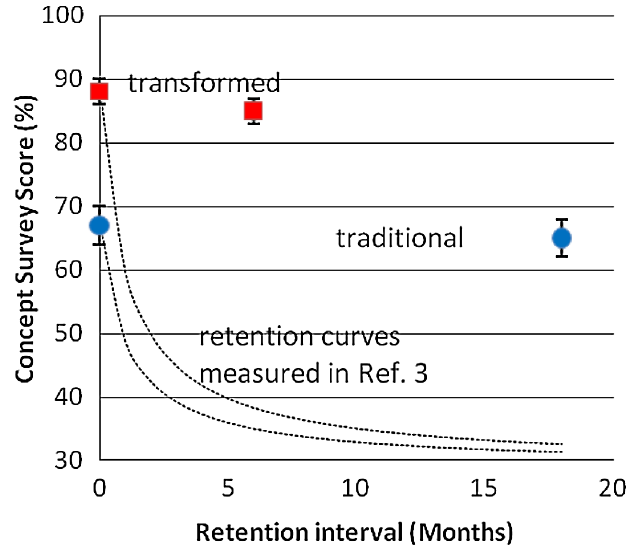
FIG. 1 (color online). Scores on the Quantum Mechanics Concept Survey (QMCS) vs retention interval. Blue circles: traditional lecture retention study group. Red squares: interactive engagement retention study group. The dashed lines are the retention curves for the average student from the university consumer behavior course measured in Ref. [3] for comparison. The curves have been scaled to a baseline of 29%, which is the QMCS score achieved by random